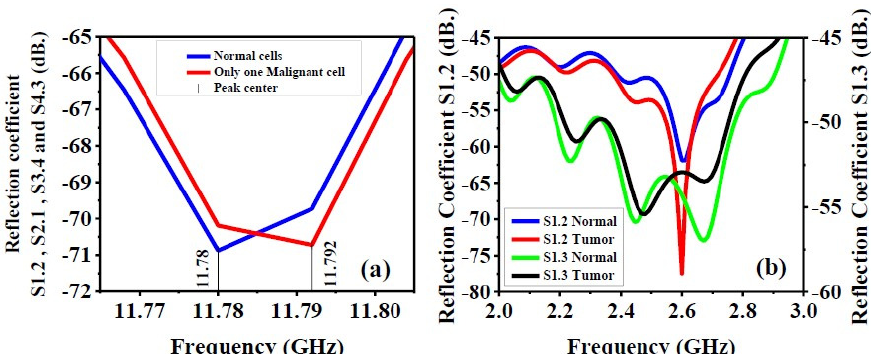
Figure 15. ( a ) Reflection coefficient with the presence of only one malignant cell inside the breast phantom. ( b ) Reflection coefficient (S-parameters) (S1.2 and S1.3) with the presence of tumor inside breast phantom.